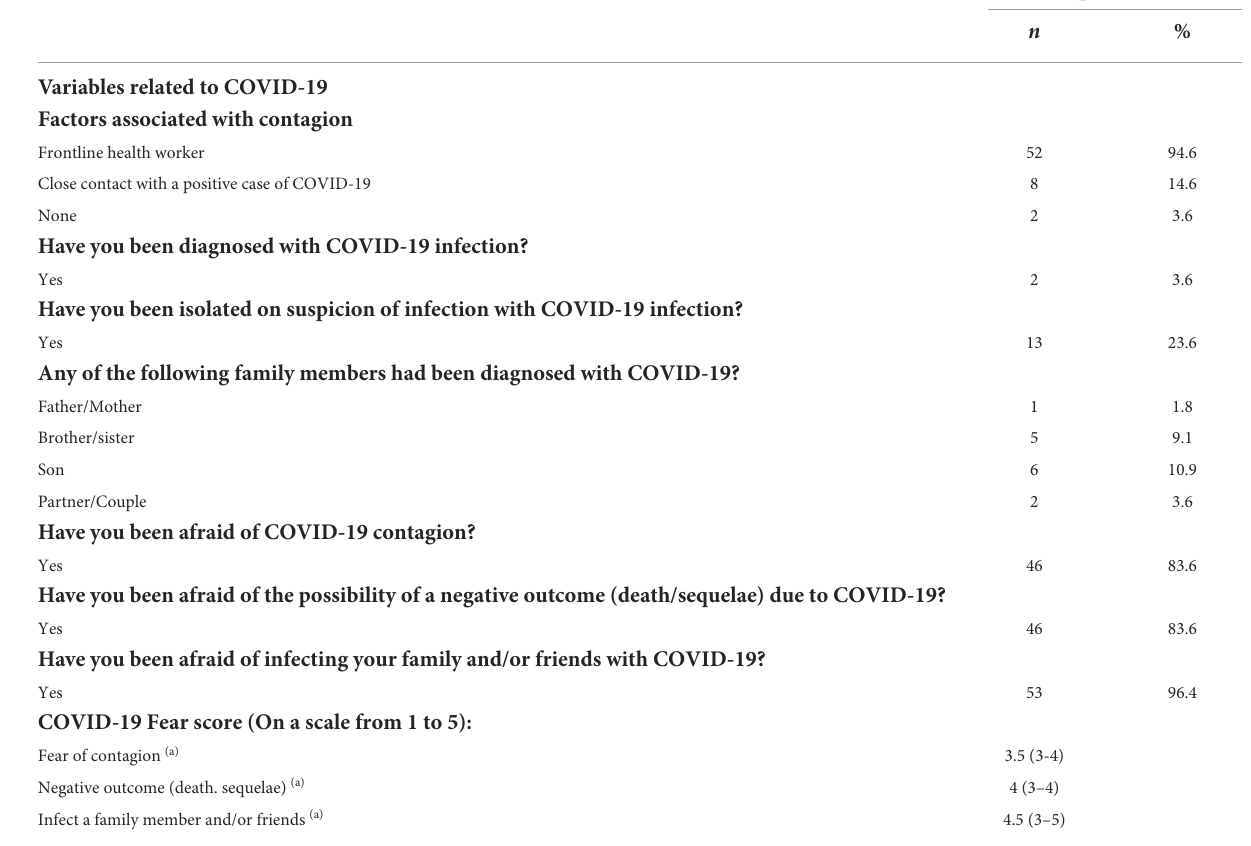
TABLE 3 Variables related to